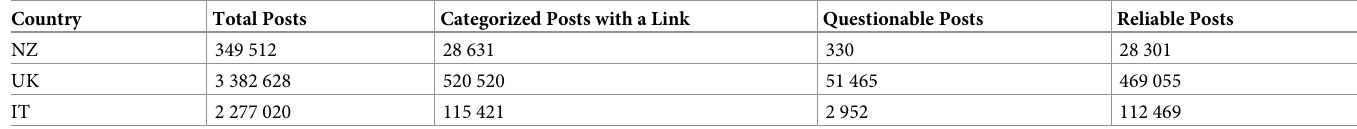
Table 2. Data breakdown of Facebook posts collected from pages whose admin was related to one of the three countries in exam, together with the results of the clas- sification process. Country Total Posts Categorized Posts with a Link Questionable Posts Reliable